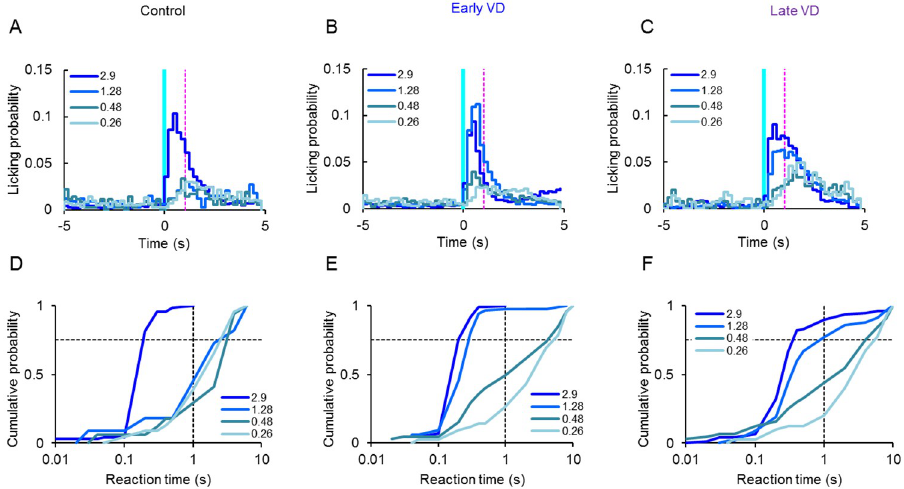
Fig 4. Licking probability and time to first lick under test 1. A-C , Histograms of licking probability before and 5 s after the onset of the LED stimulus cue (blue vertical line) of the same rat, the control (A), the early VD (B), the late VD (C). Each magenta broken line was drawn at 1 s after the cue stimulus. D-F , Cumulative probability plots of the reaction time of the same rats shown previously. The vertical broken lines was drawn at 1 s while the horizontal one at